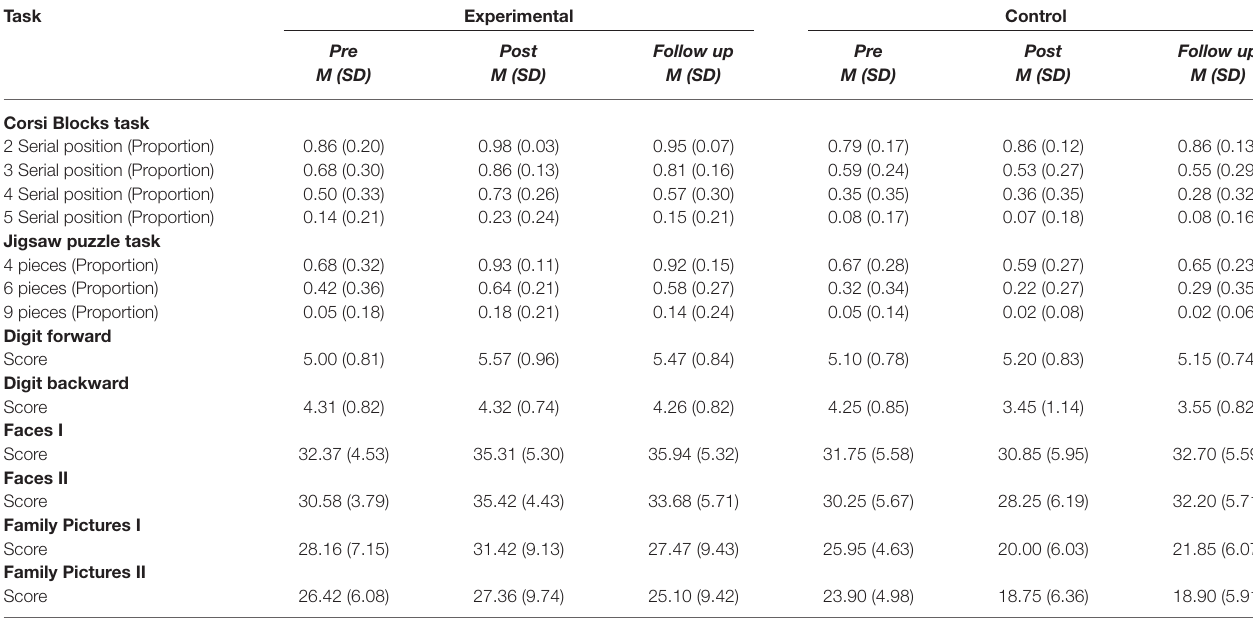
TABLE 3 | Pre-test, post-test and follow-up training performance on working memory and episodic memory tasks corresponding to the trained and the control groups. M (Mean), SD (Standard deviation). Task Experimental Control Pre Post Follow up Pre Post Follow up M (SD) M (SD) M (SD) M (SD) M (SD) M (SD) Corsi Blocks task 2 Serial position